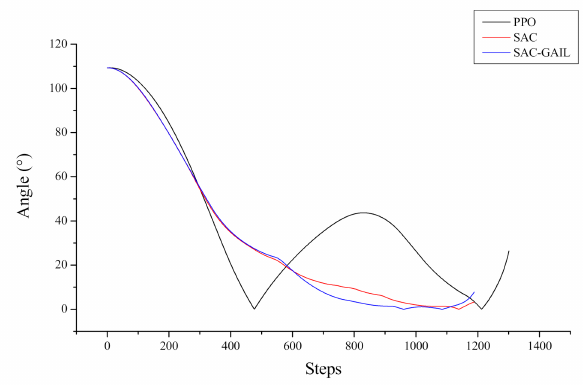
Figure 18. Angle curve of